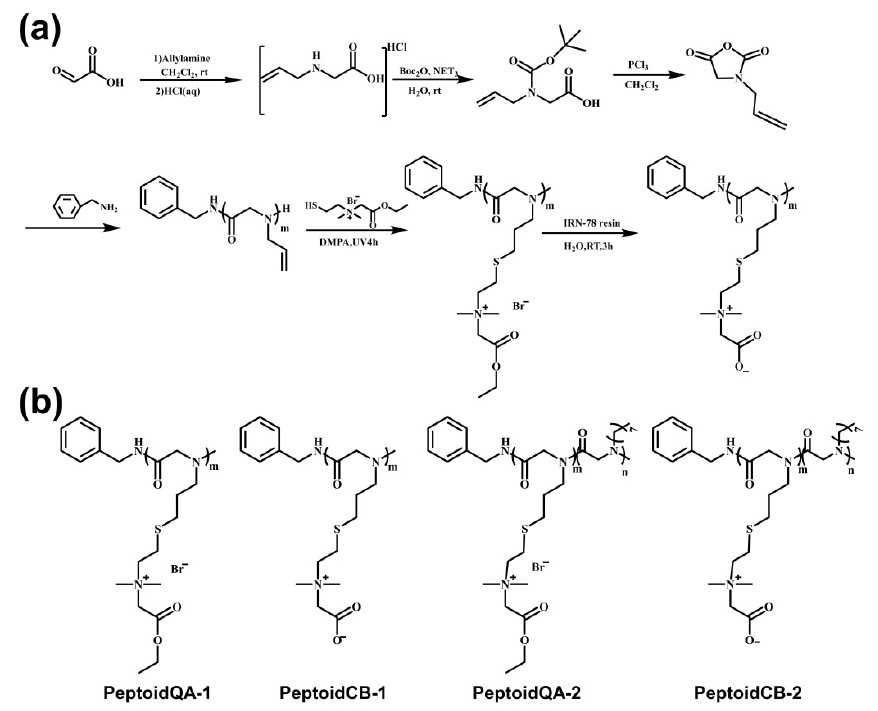
Table 1. Characteristics of the polymers synthesized.